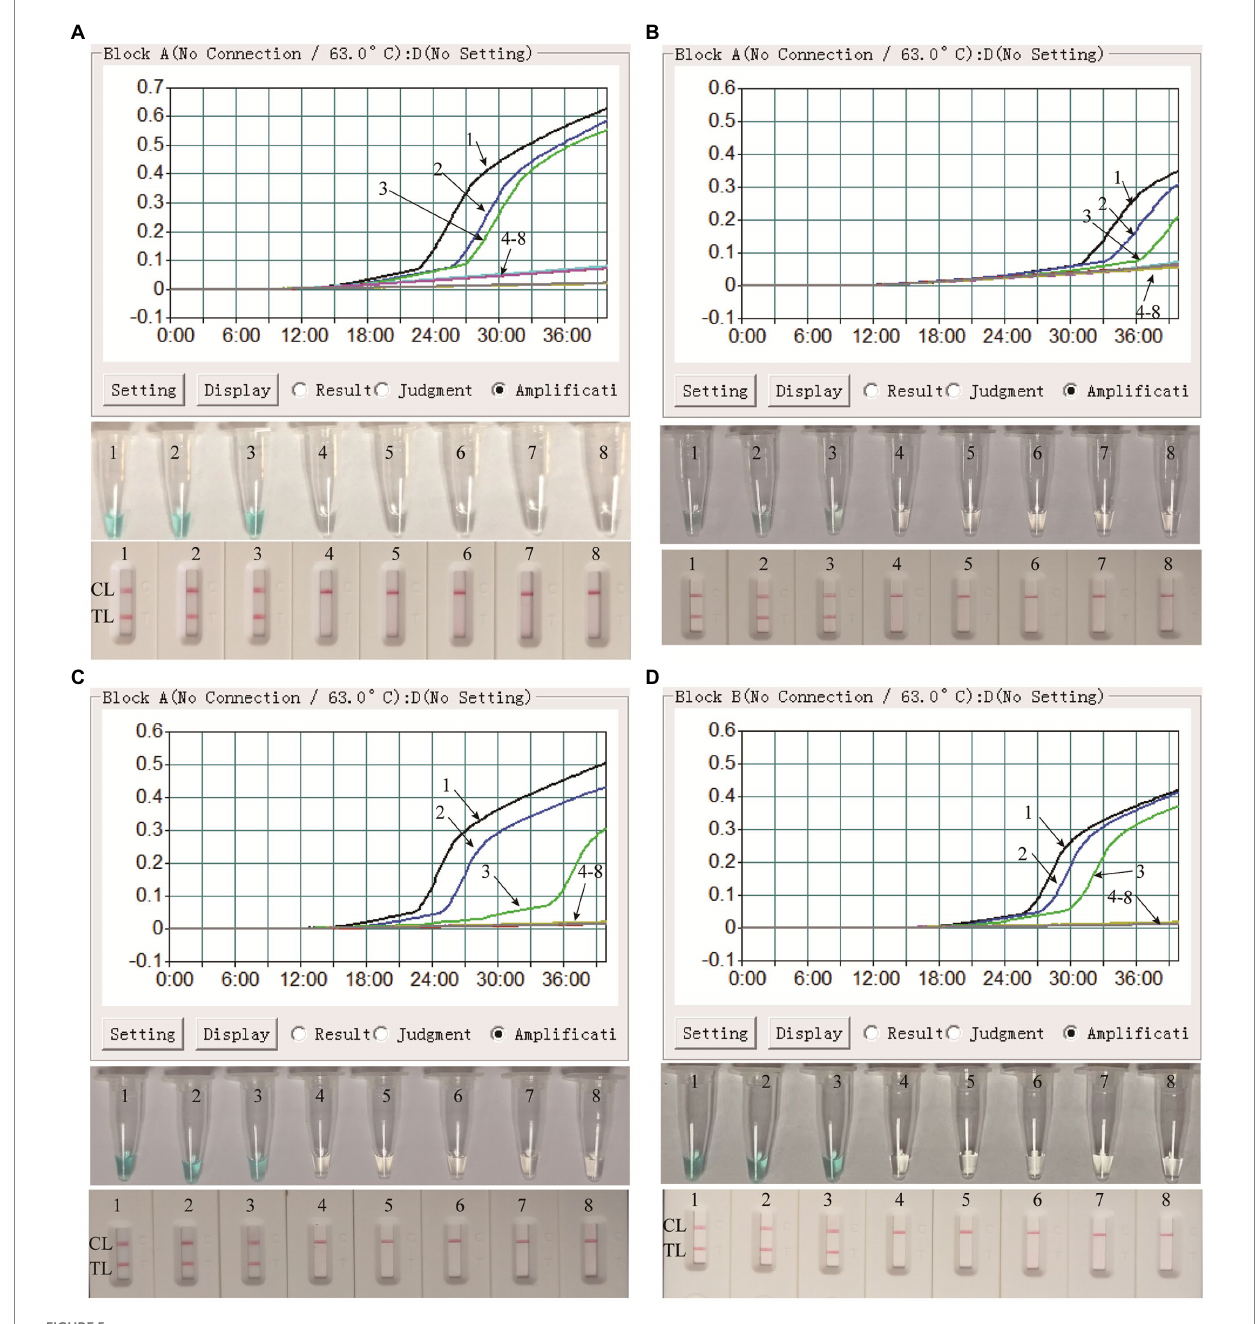
FIGURE 5 Clinical feasibility confirmation of the MPX-LAMP-LFB assay in simulated blood and lesional swab specimens. Clinical feasibility of the MPX-LAMP-LFB assay was confirmed by using the serially diluted simulated blood specimens with nucleic acid extraction process (A) and without nucleic acid extraction process (B) , and the serially diluted simulated lesional swab specimens with nucleic acid extraction process (C) and without nucleic acid extraction process (D) . All the specimens were detected using turbidity (top row), visual detection reagent (middle row)and LFB (bottom row). Curves/ Tubes/Biosensors 1–8 represented the amplification results of the pseudotyped virus levels in blood samples of 1.25 × 10 3 , 1.25 × 10 2 , 1.25 × 10 1 , 1.25 × 10 0 , 1.25 × 10 − 1 , 1.25 × 10 − 2 , and 1.25 × 10 − 3 copies permicroliter and DW.TL, test line; CL, control